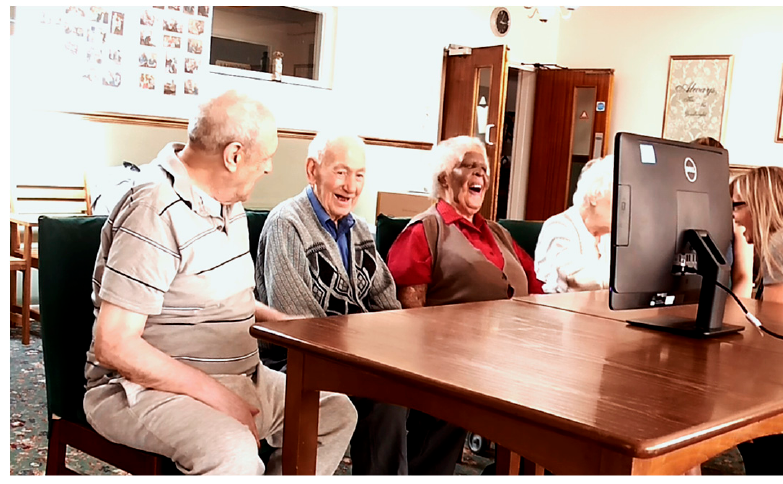
Figure 4. An example of group interactions involving CIRCA.